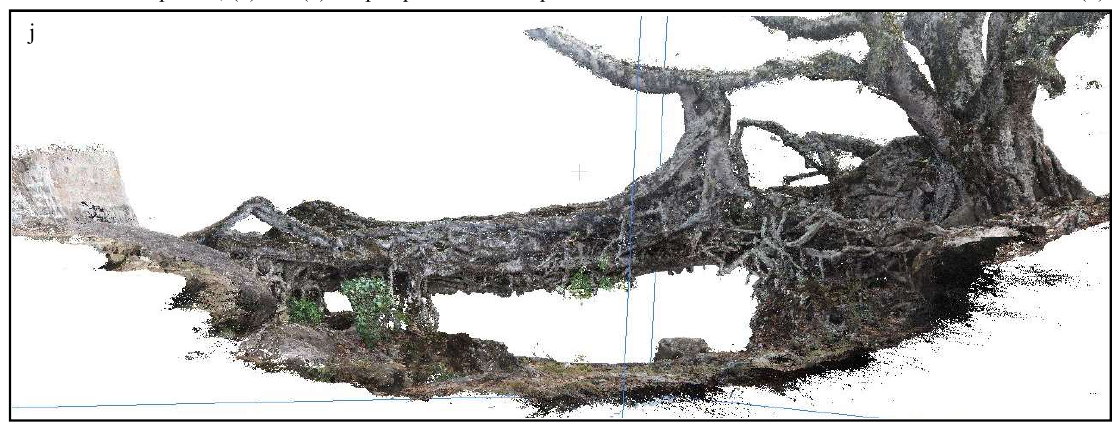
Figure 4: The bridge in the centre of Nongbareh village shows burns on the surface (a, b) and calluses on the top of the handrails, that allow water to pool (c, d). (a) and (c) are photos, (b) and (d) are perspectives of the point cloud.